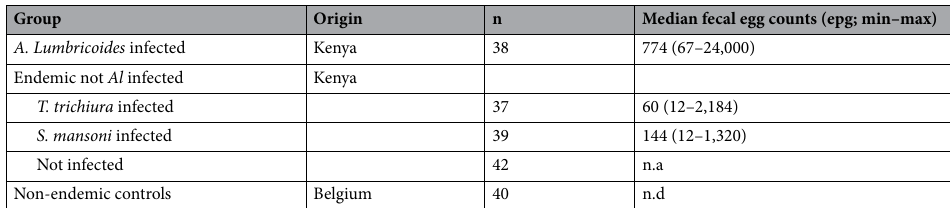
Table 1. Overview of samples used in metabolomic profiling. All samples were divided in two groups: one infected with only A. lumbricoides and one not infected with A. lumbricoides . For the latter group, individuals infected with T. trichiura , hookworm and S. mansoni based on microscopic egg counting by the Kato-Katz thick smear are listed. epg: eggs per gram of stool; n.a.: not applicable; n.d.: not